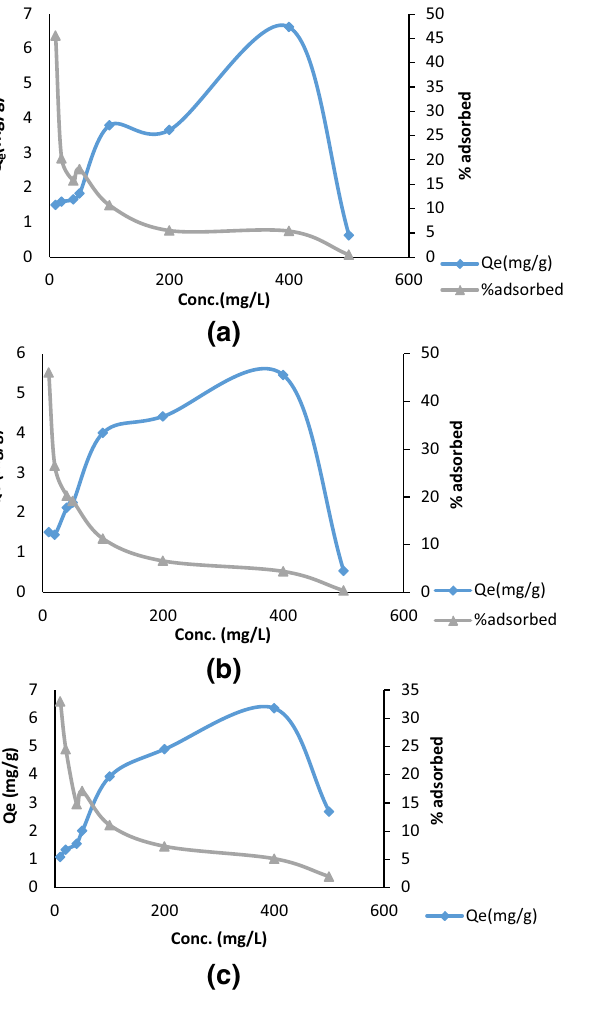
Fig. 4 a Concentration profile diagram for Cr(VI)//G, b concentration profile diagram for Cr(VI)//AC system, c concentration profile dia- gram for Cr(VI)//GAC system